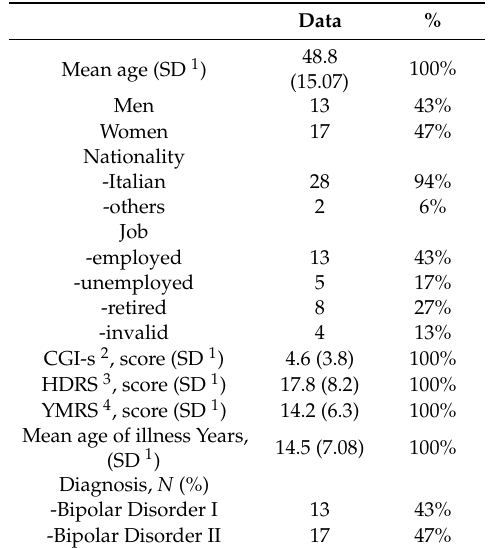
Table 1. Sociodemographic and clinical